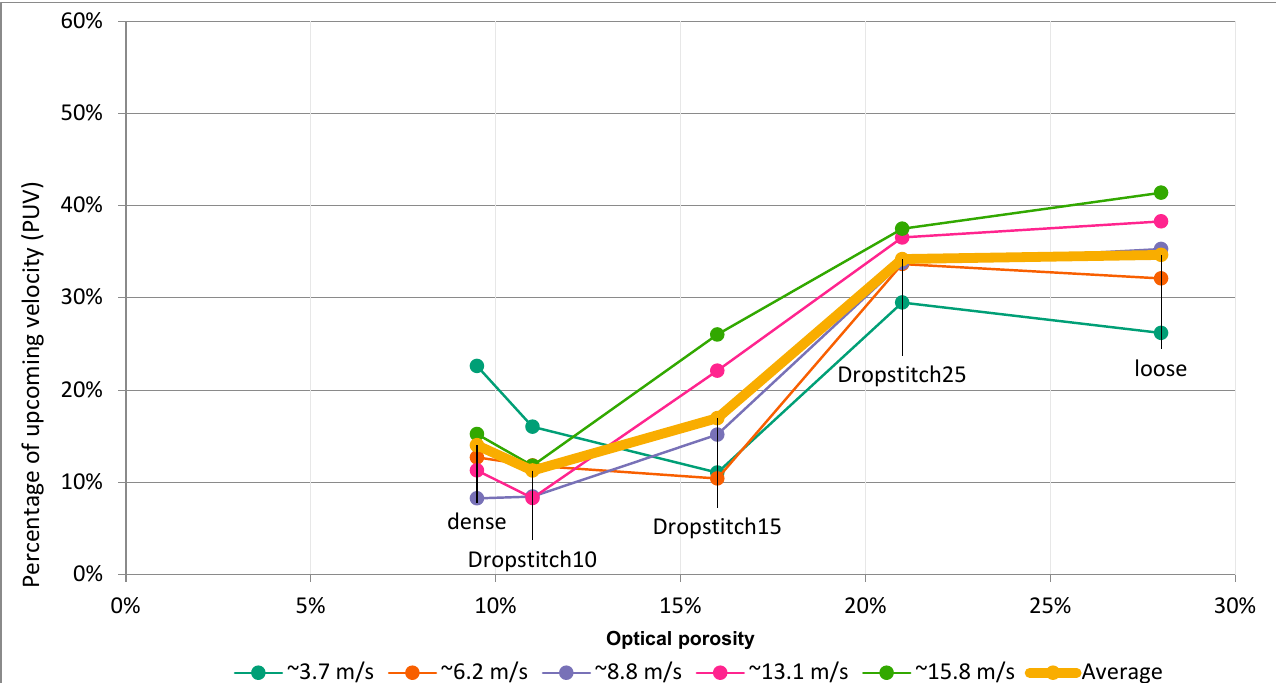
Figure 14. Percentage of upcoming velocity (PUV) depending on the calculated optical porosity.